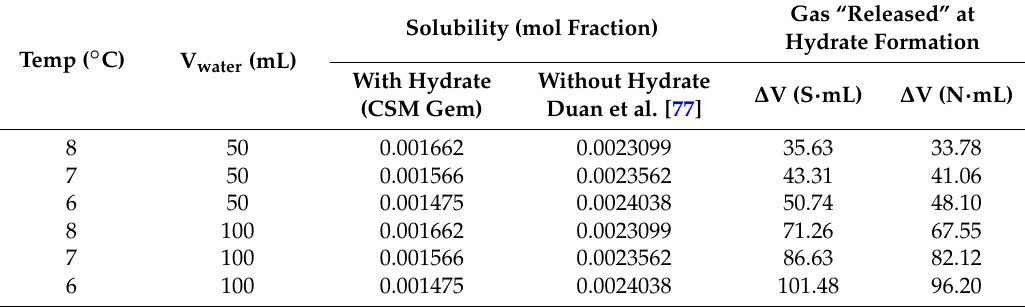
Table 2. Solubility of methane in water in systems with and without hydrates. The right-hand columns show the volume of excess gas at incipient hydrate formation due to reduced solubility in system with hydrate in standard mL (S · mL, T ref = 15 ◦ C) and normal mL (N · mL, T ref = 0 ◦ C), respectively.